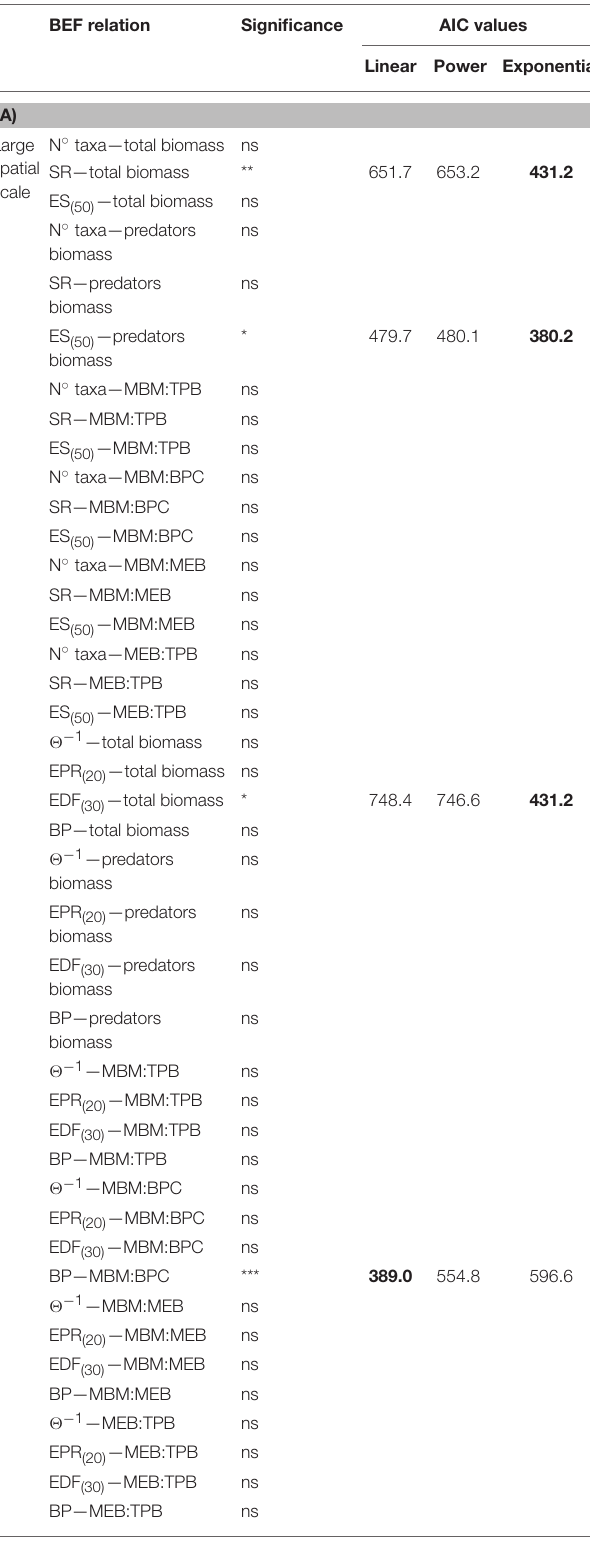
TABLE 2 | Complete list of significant and non-significant BEF relations reported (A) on large spatial scale and (B) on basin spatial scale. BEF